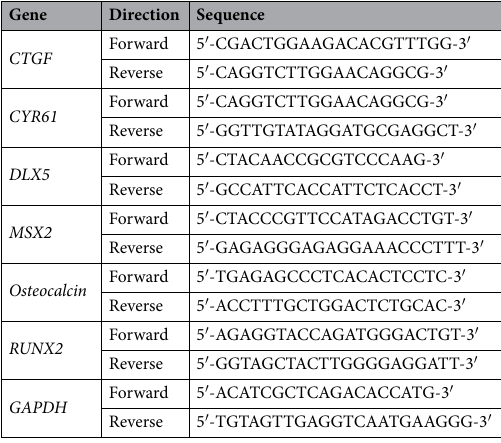
Table 1. Primers for